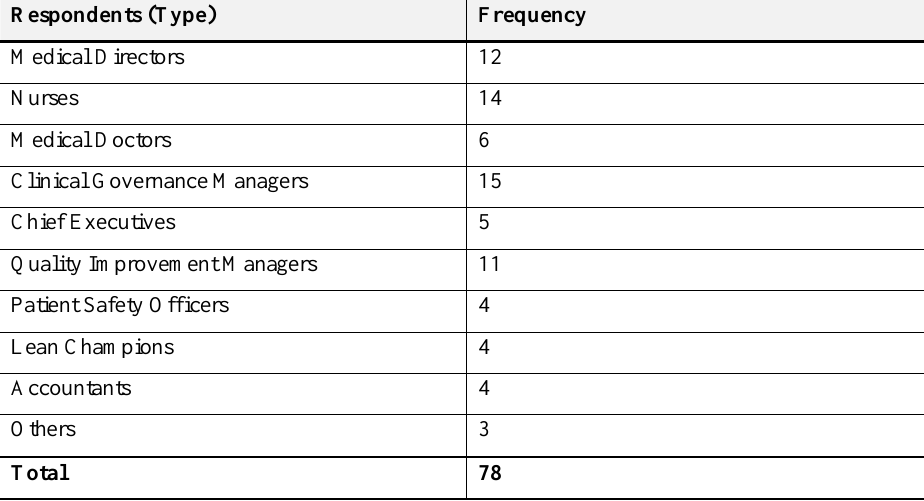
Table 1 – Breakdown of respondents to the survey